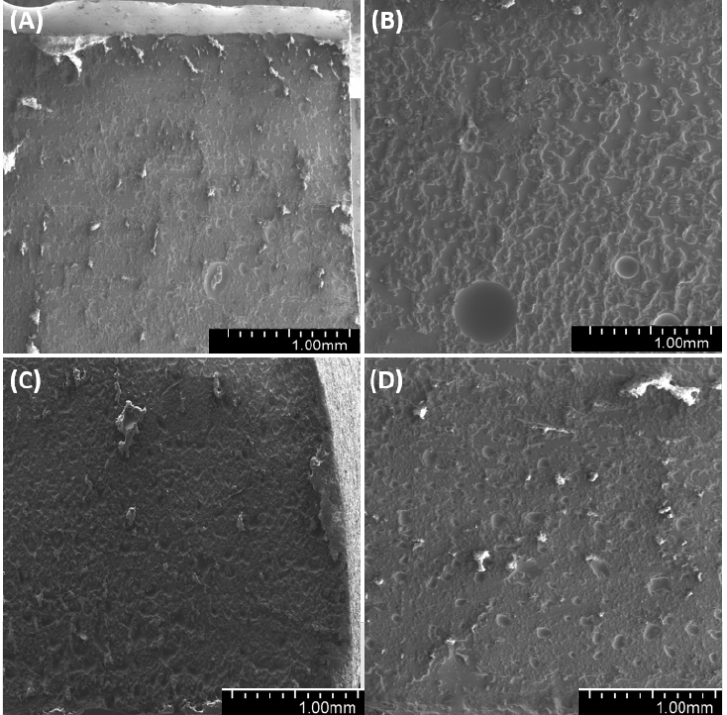
Figure 26. SEM images of mold wall with 48% vol. of diatoms: ( A )—base deg, ( B )—base no deg, ( C )—fractionated deg, ( D )—fractionated no deg.